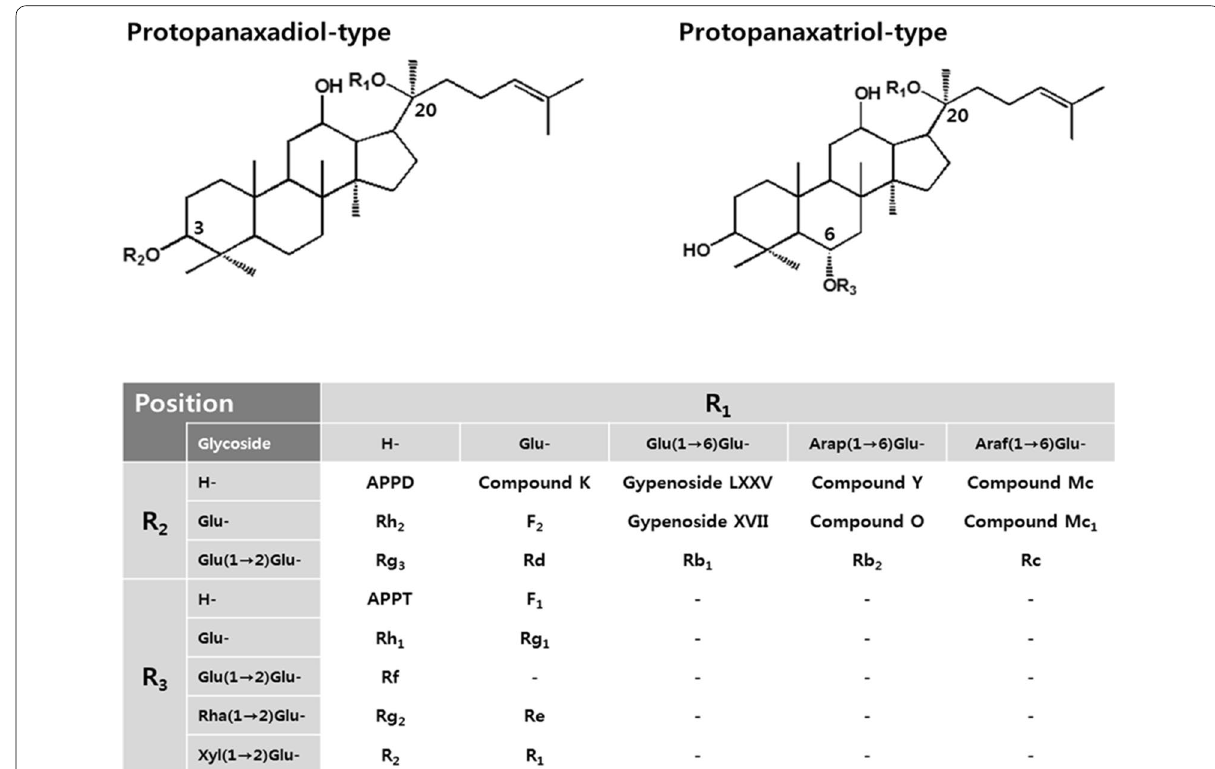
Fig. 1 Chemical structures of protopanaxadiol (PPD) and protopanaxatriol (PPT)‑type ginsenosides. Glu β‑ d ‑glucopyranosyl, Arap α‑ l ‑ arabinopyranosyl, Araf α‑ l ‑arabinofuranosyl, Rha , α‑ l ‑rhamnopyranosyl, Xyl , β‑ d